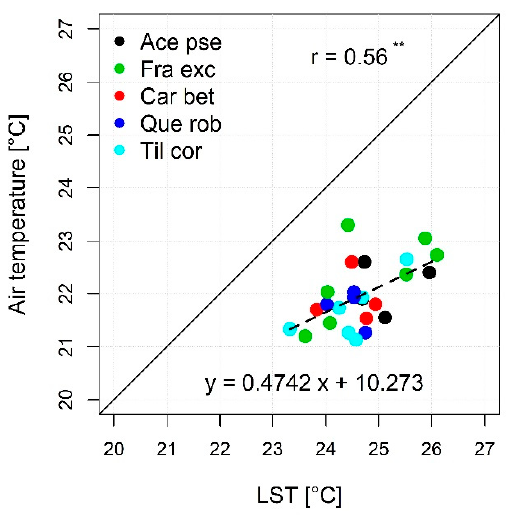
Figure 5. Relationship between tree crown air temperature and gyrocopter LST at 0.4 m resolution ( n = 25); asterisk indicates the significance of the correlation (n.s. p > 0.05, * p < 0.05, ** p < 0.01, *** p < 0.001).